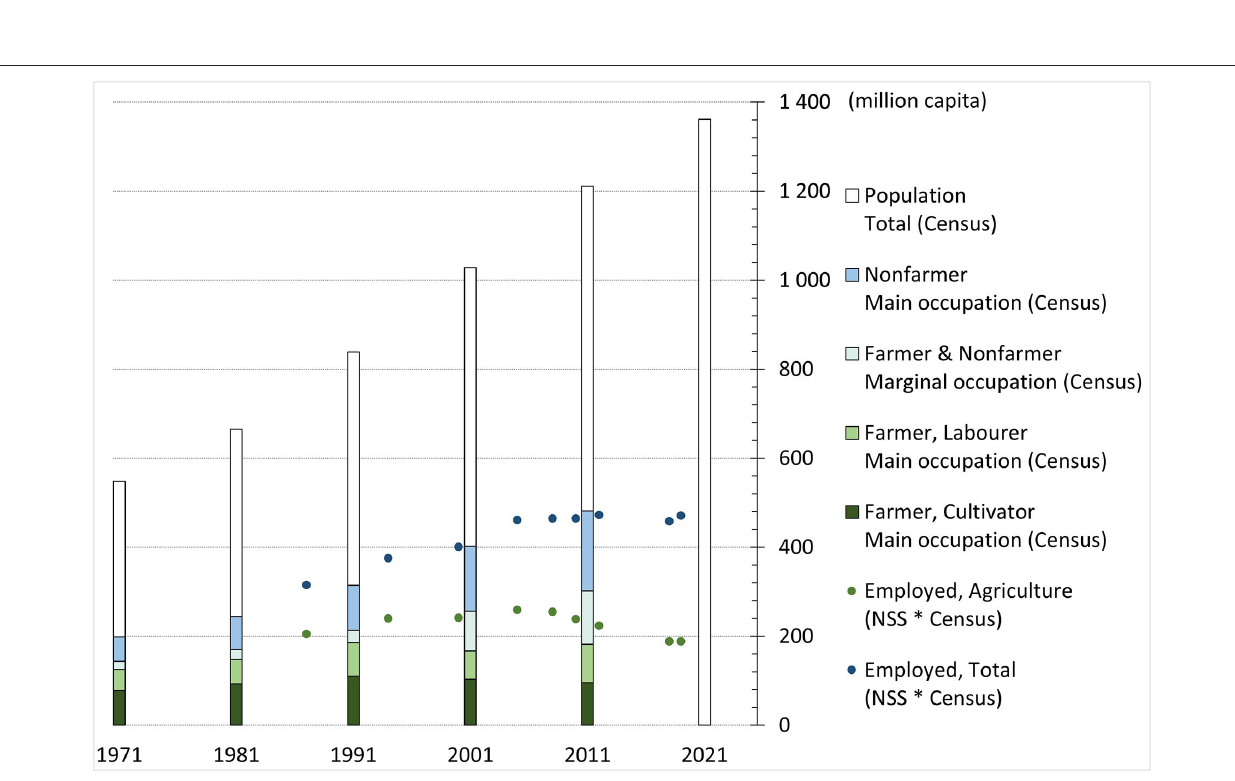
Frontiers in Sustainable Food Systems |